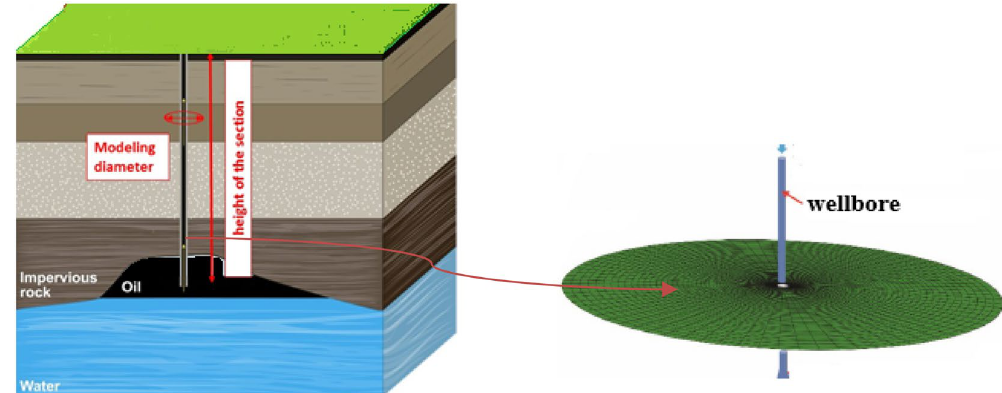
Fig. 3 Schematic of wellbore trajectory and model geometry for hydro-mechanical model